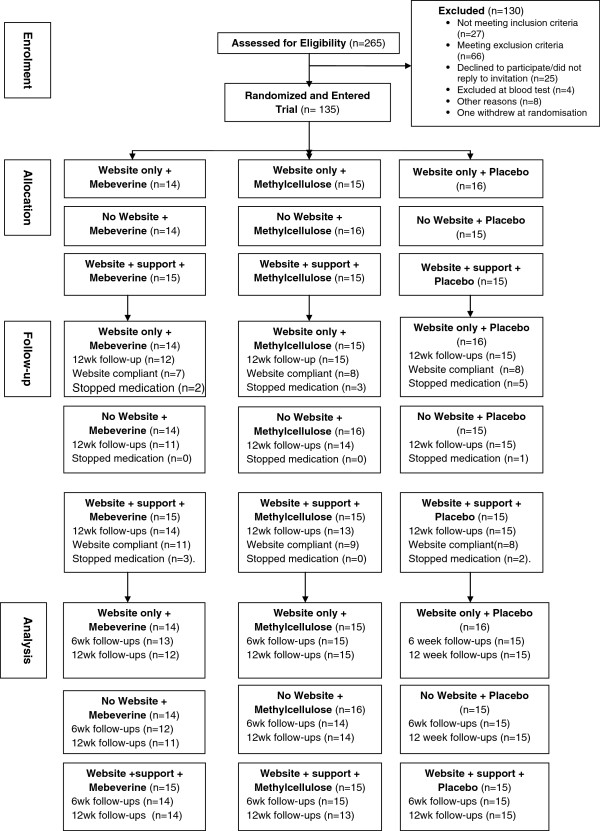
CONSORT diagram.